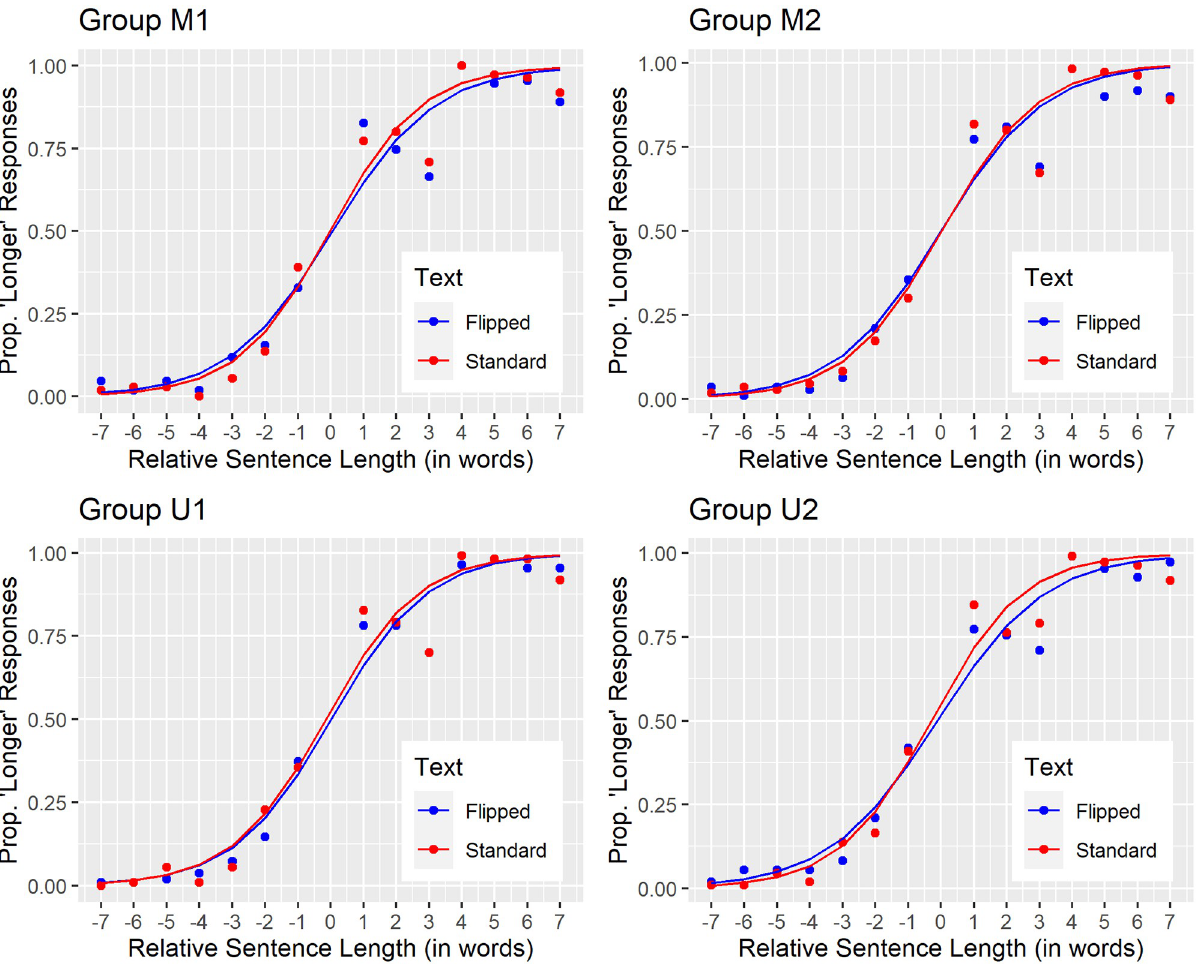
Fig 4. Psychometric functions. Each panel corresponds to a different group of 22 participants. At each relative sentence length, individual data points reflect the mean proportion of “longer” sentence-length responses separately for standard (red) and flipped (blue) text. Standard text (red) generated psychometric functions with only marginally steeper slopes than did flipped text (blue) across groups. This consistent but small “inversion effect” for the precision of sentence-length judgments held for mirror-reversed (Groups M1 and M2) and upside-down text (Groups U1 and U2) alike. The midpoint (point of subjective equality, PSE) of each psychometric function tended toward zero, indicating minimal response bias near the center of the sentence-length range.